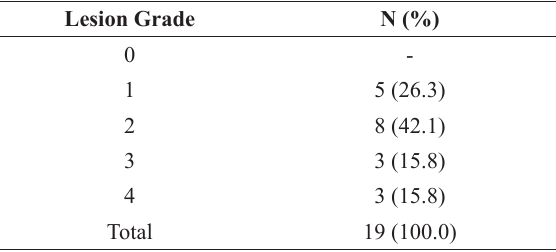
Frequencies of macroscopic Vaginal Lesion Scores (VLS) in the vaginal mucosa of 19 heifers positive for Ureaplama diversum.